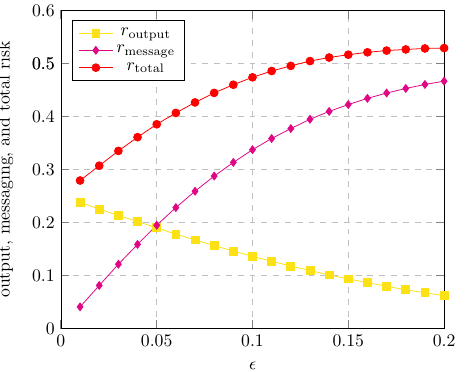
Figure 3. Private communication: The risk of the Quorum-Sensing protocol. The magenta plot depicts the message risk r message incurred by a rebel running the Quorum-Sensing protocol in the private communication model, when facing the Reverse police protocol. See more details in “Methods”. As in Fig. 2, the output risk r output (yellow plot) denotes the percentage of rebels which output “many” when ρ = 0.2 (i.e, “few rebels”), and r total (red plot) is simply the sum of r output and r message . The simulations should be compared with the simulations shown in Fig.